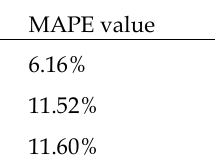
Table 3. Case study I MAPE values of each travel time prediction